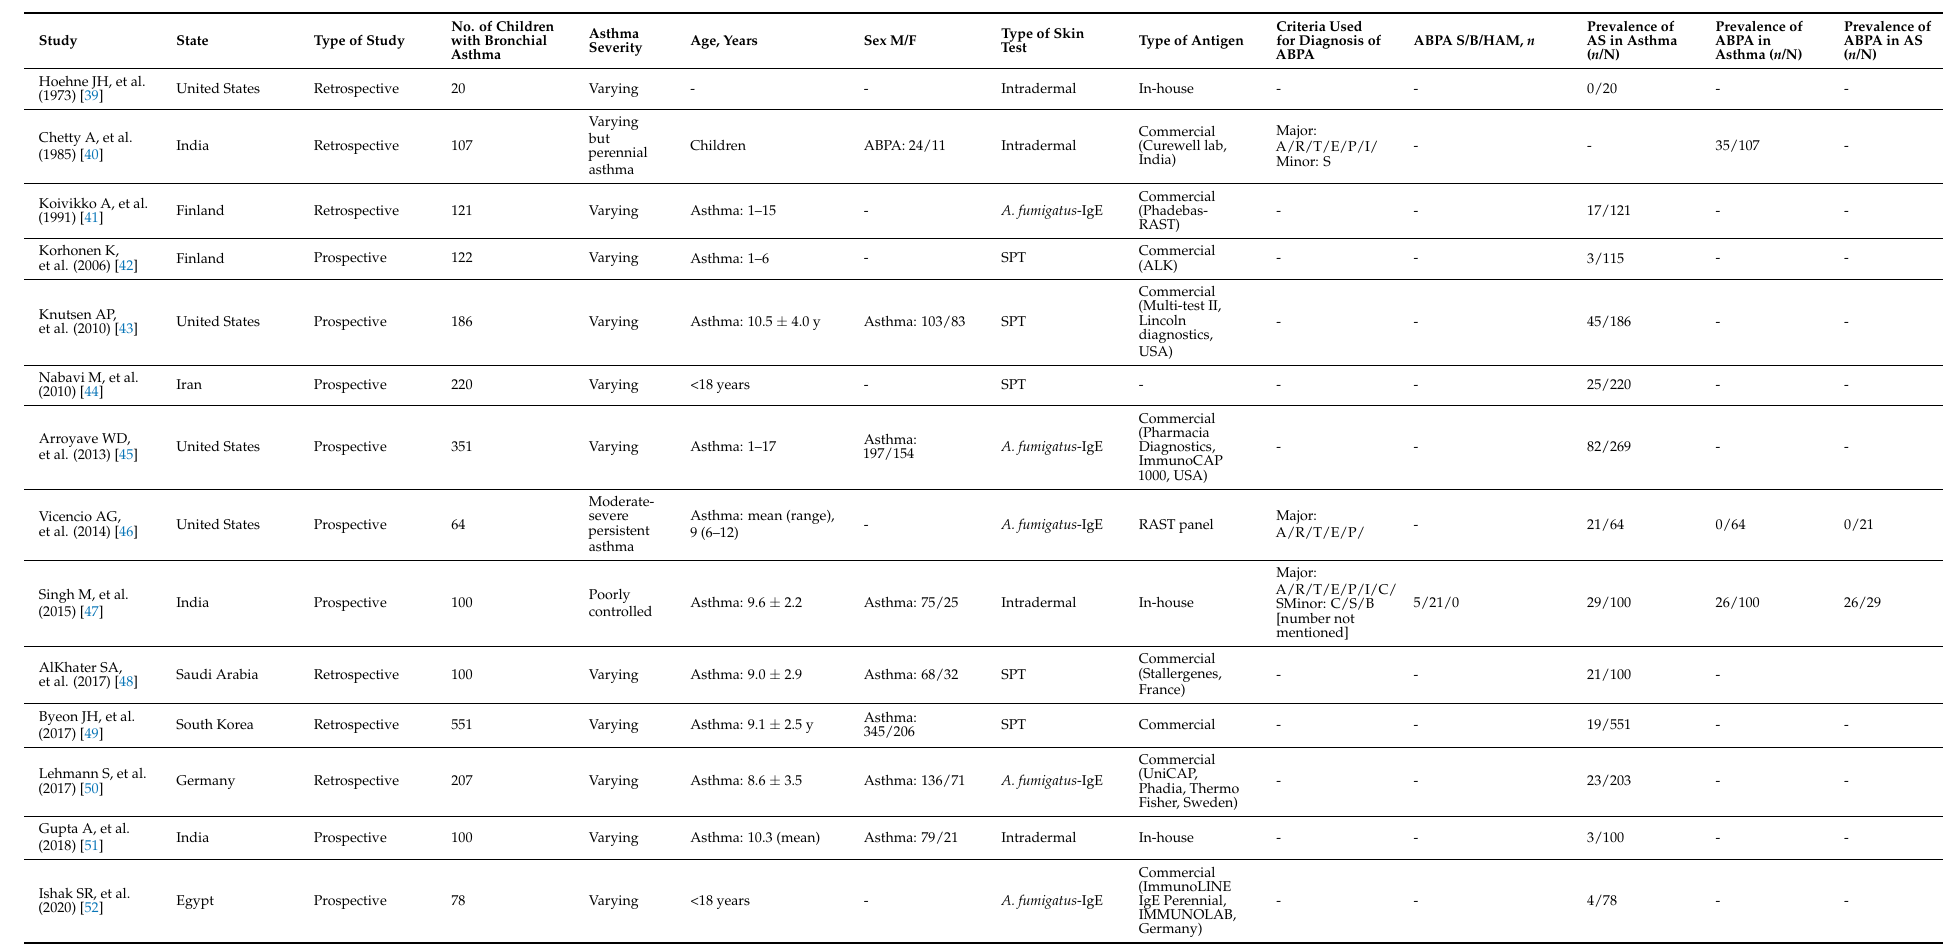
Table 1. Studies describing the prevalence of Aspergillus sensitization (AS) or allergic bronchopulmonary aspergillosis (ABPA) in children with bronchial